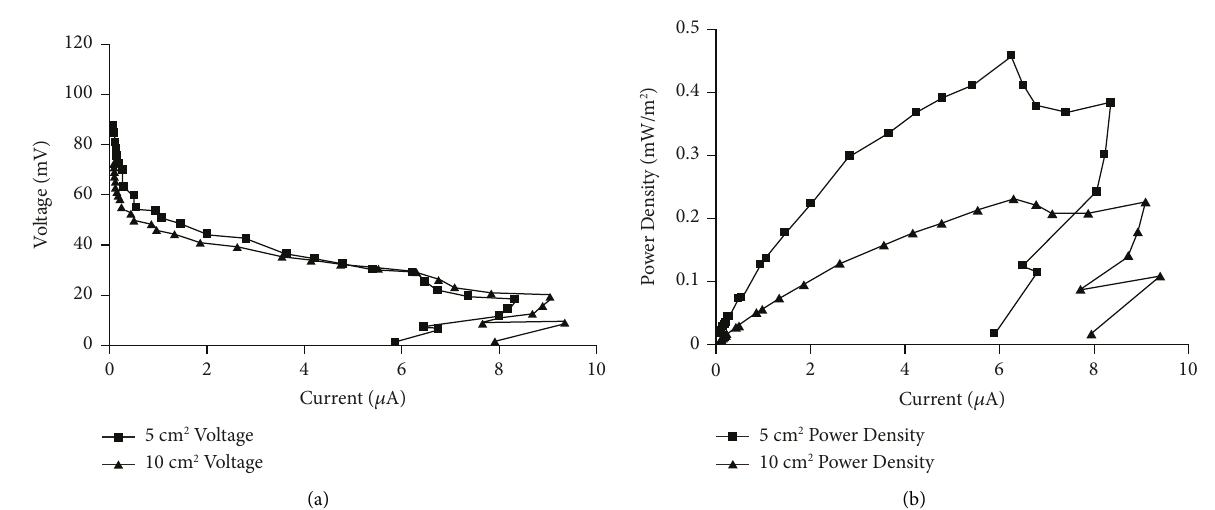
Figure 1: (a) shows the polarization curve, while (b) shows the corresponding power curves for MFCs with 5cm 2 and 10cm 2 electrode surface area measured on day 6 of normal operation from a dual-chambered MFC at pH 6.4, with H. salinarum as the anodic organism at a ratio of 1: 24, maintained at 37 ° C under nonoscillating conditions.